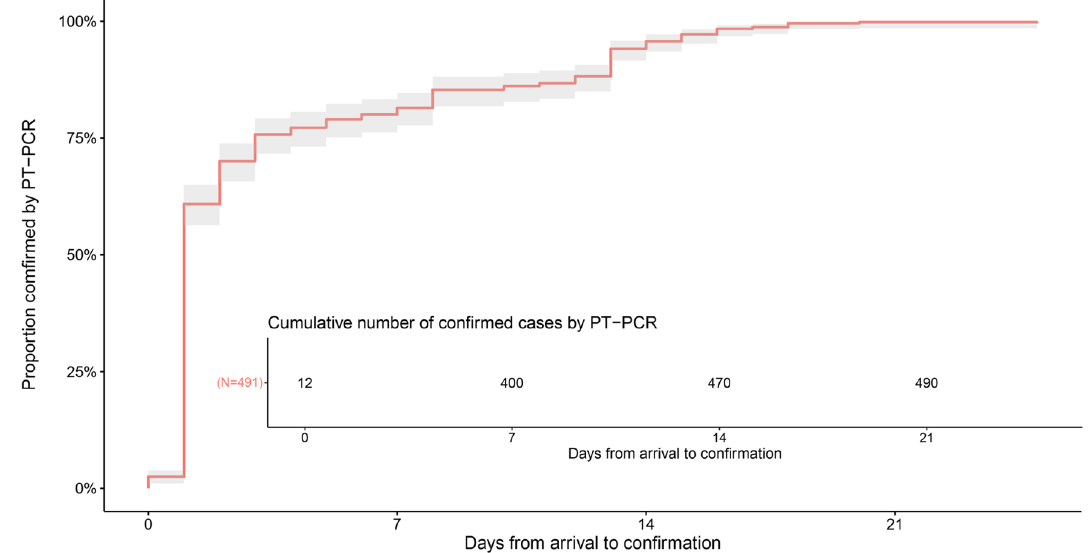
Figure 1. Time between arrival in Chengdu and SARS-CoV-2 confirmation. We estimated that 95% of cases were confirmed by PT-PCR within 14 days (95% CI 13–15) after arriving in Chengdu.